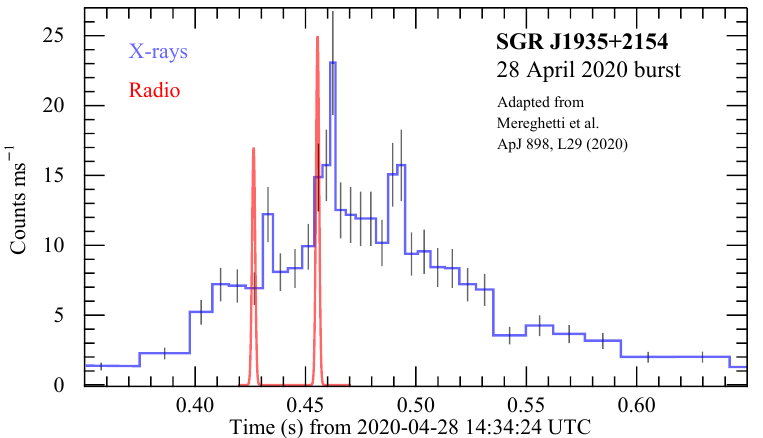
Figure 7. INTEGRAL/IBIS-ISGRI time profile of the bright X-ray burst (20–200 keV) from Soft Gamma Repeater (SGR) J1935 associated with FRB 20200428A. The red profile shows the FRB 20200428A radio pulses as observed with CHIME (adapted with permission from Mereghetti, S., et al.; published by IOP Publishing, 2020